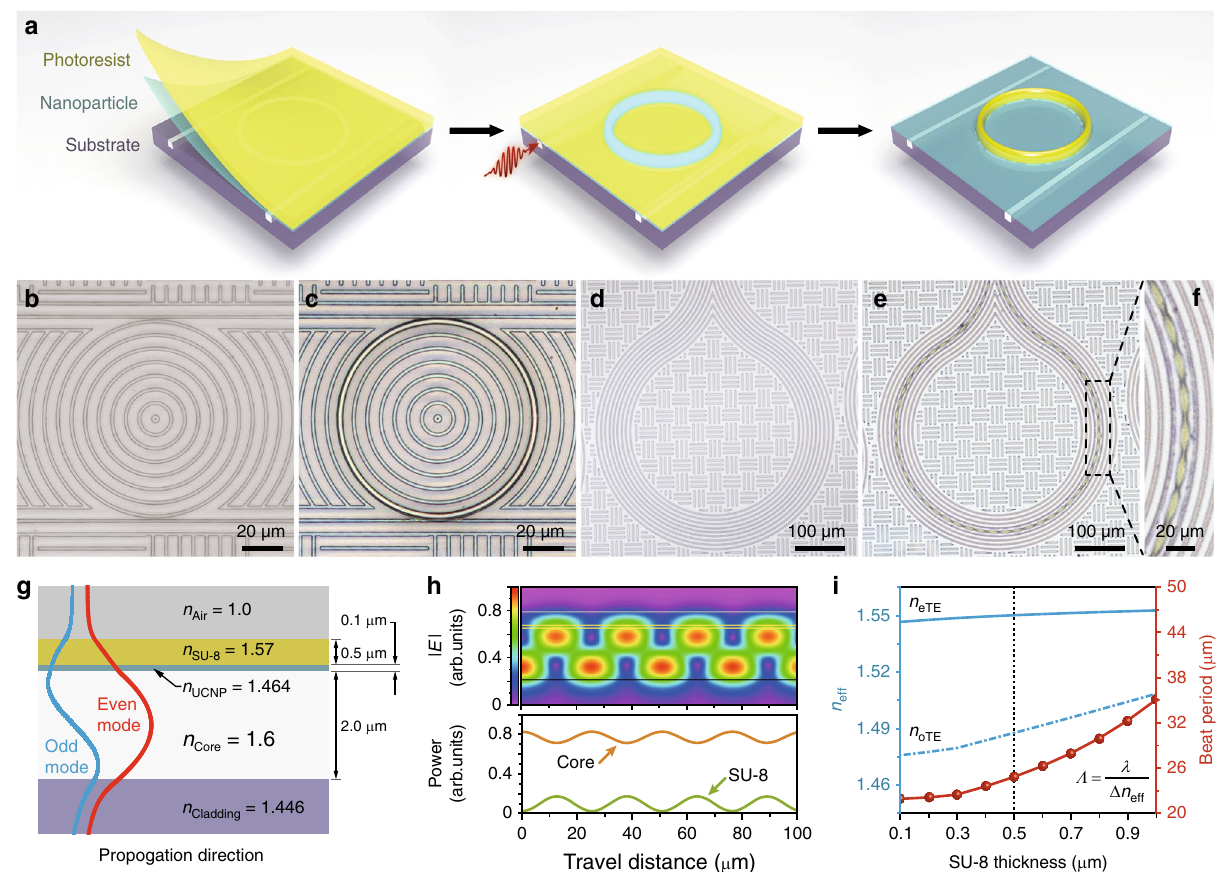
Fig. 5 Photolithography with the UV emission for precise formation of waveguides and patterns. a Schematic design for patterning SU-8 photoresist. NaErF 4 @NaYF 4 upconversion nanoparticles and SU-8 fi lm are deposited on the substrate. Locally generated upconversion light by the waveguide structure induces selective exposure of SU-8 fi lm. b , c Micrographs of a microring resonator before and after developing a SU-8 layer on the ring. d – f Micrographs